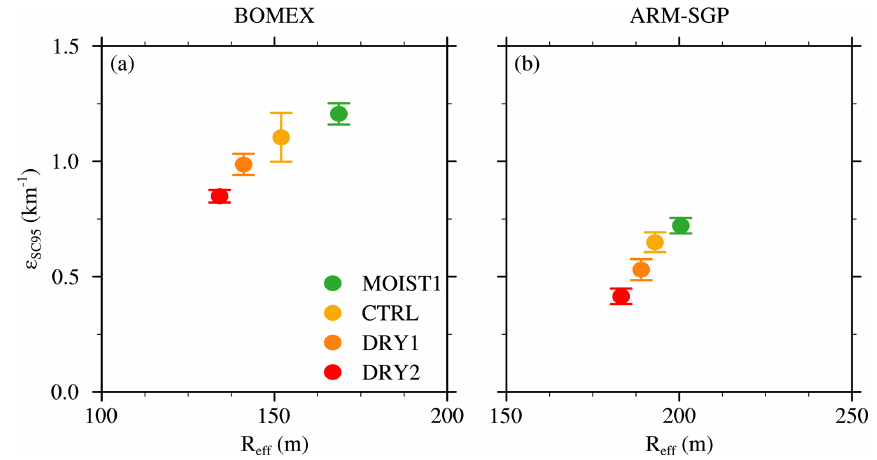
Figure 15. Fractional dilution rate ( ε SC95 ) as a function of effective cloud radius ( R eff ) for (a) the maritime BOMEX cases and (b) the continental ARM-SGP